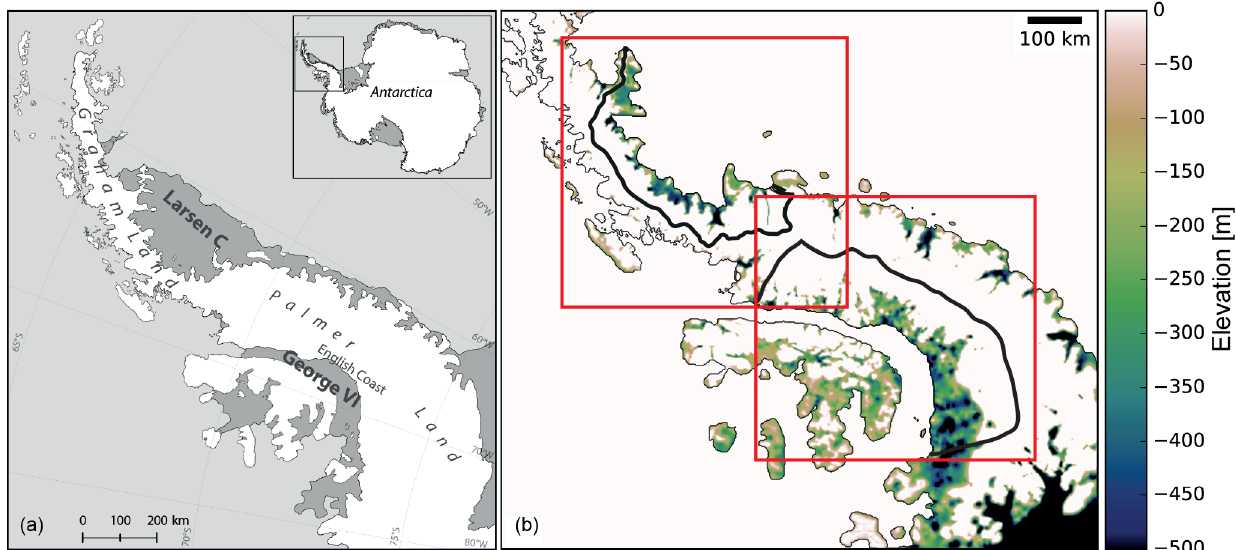
Figure 1. (a) Location map of the Antarctic Peninsula including locations of Larsen C and George VI ice shelves and localities mentioned in the text. (b) Bedrock elevations below sea level in metres for the Antarctic Peninsula from BEDMAP2 (Fretwell et al., 2013). The colour bar is truncated at 0m. Red inset rectangles delineate the locations of zoomed-in areas in Figs. 2, 5, 6, and 8. Black polygons denote ice-sheet model